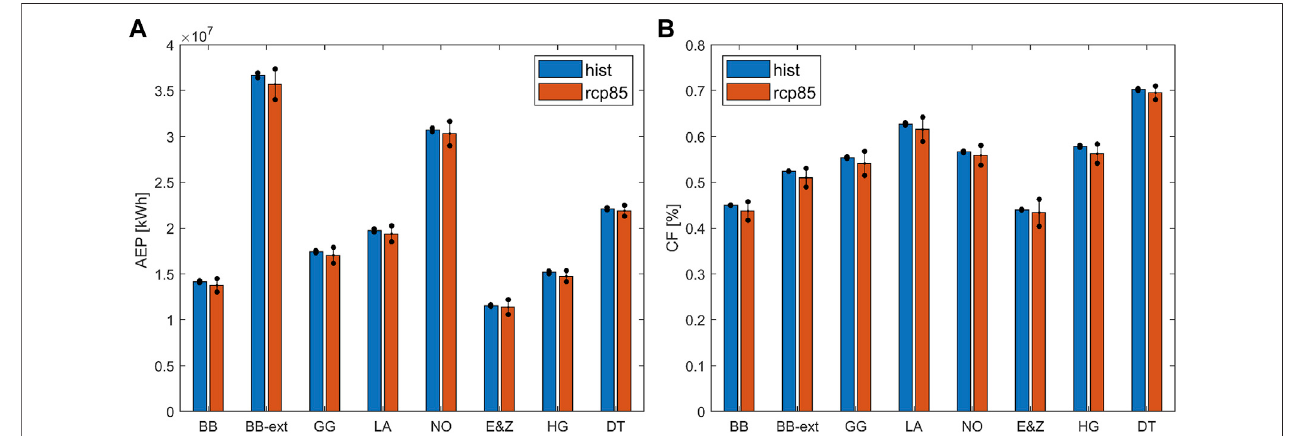
FIGURE11| Future(orange)andhistorical(blue)ensemblemeanvaluesofAnnualEnergyProduction (A) andCapacityFactor (B) foralltheoffshoredevelopments analyzed. Black dots indicate the range individuated by the mean value ±1.5 times the standard deviation.